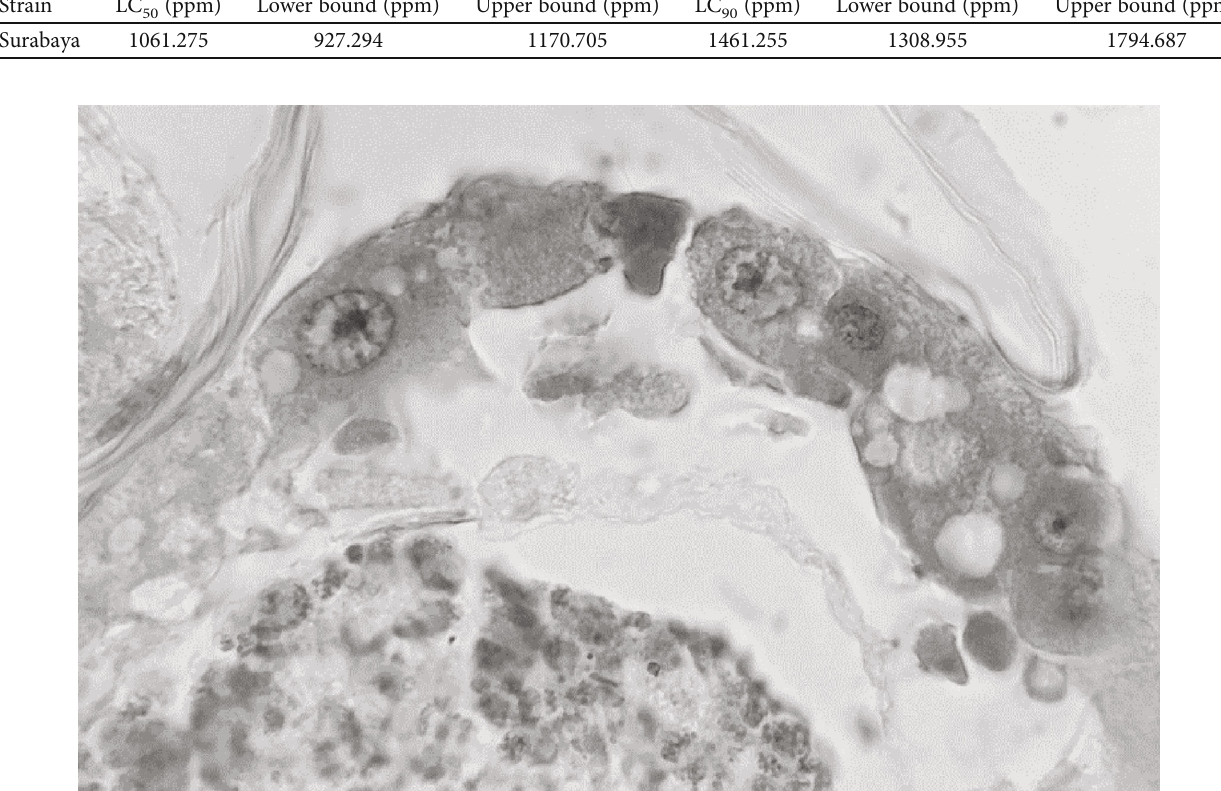
Table 2: LC and LC of Averrhoa bilimbi extract based on mortality of third-instar Ae. aegypti larvae after 24 hours of exposure. 50 90 Strain LC (ppm) Lower bound (ppm) 50